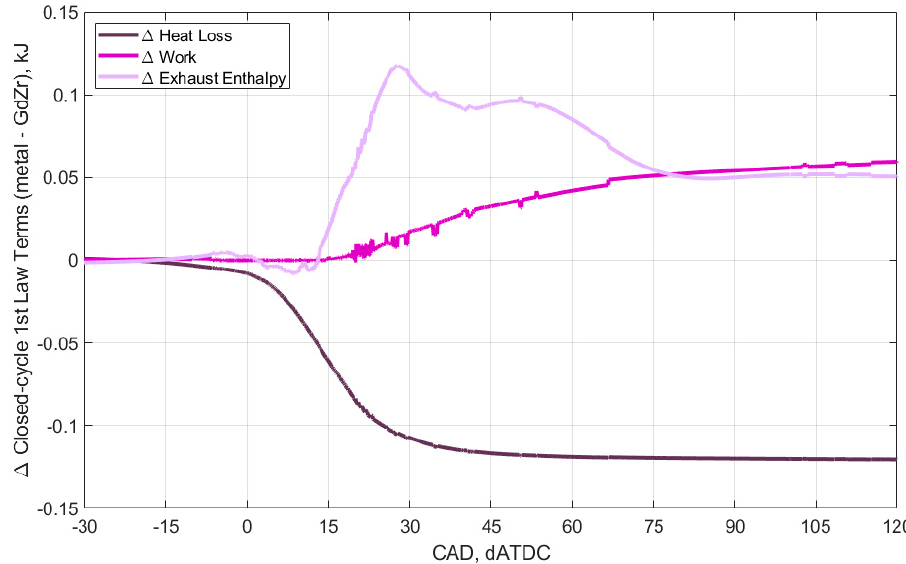
Figure 7. Closed cycle first law analysis comparison for the TBC and metal cases, positive indicating that the metal case had higher values than the coated case. that the metal case had higher values than the coated